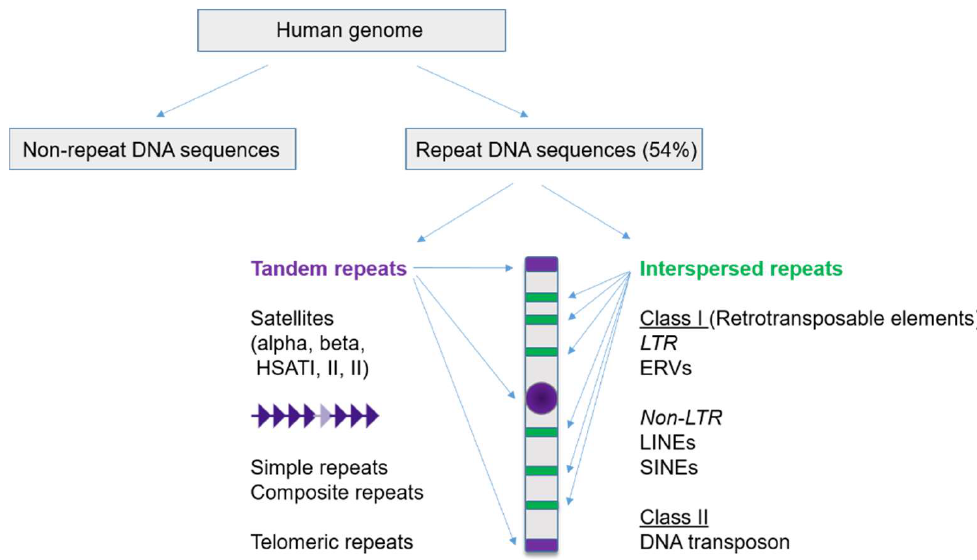
Figure 1. Schematic representation of the classification of repetitive elements in the human genome. These comprise more than 50% of the human genome and are divided into tandem and interspersed repeats, respectively. Among the tandem repeats are those that are enriched at centromeres, pericentromeres and telomeres (schematized as purple chromatin domains on the chromosome cartoon). Interspersed repeats—indicated as the green chromatin domains on the chromosome cartoon (not to scale)—include the endogenous retroelements and DNA transposons. The interspersed repeats are present along chromosome arms, including near gene promoters, where they may contribute to gene regulation, or are localized in intergenic regions. The interspersed repeats are further divided into class I and II repeats, as indicated. Abbreviations: SINE, short interspersed element; ERV, endogenous retrovirus; LTR, long terminal repeat; SVA, SINE—variable number tandem repeat—Alu; LINE, long interspersed element (see text for further details).